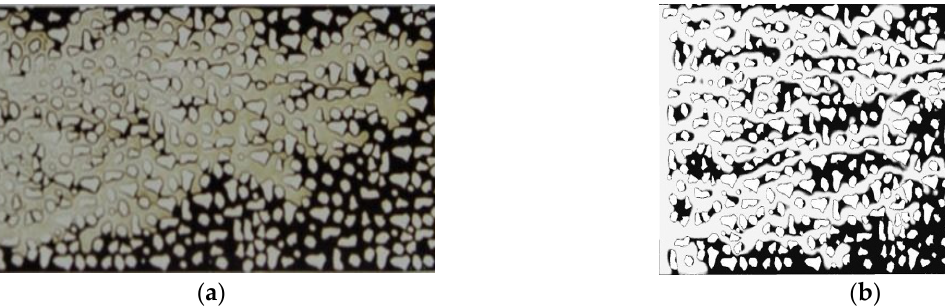
Figure 6. Flow distribution within the micromodel at rupture time. Injection velocity: 10 ft/day and IFT 0.03 mN/m. ( a ) Experimental and ( b ) simulation.